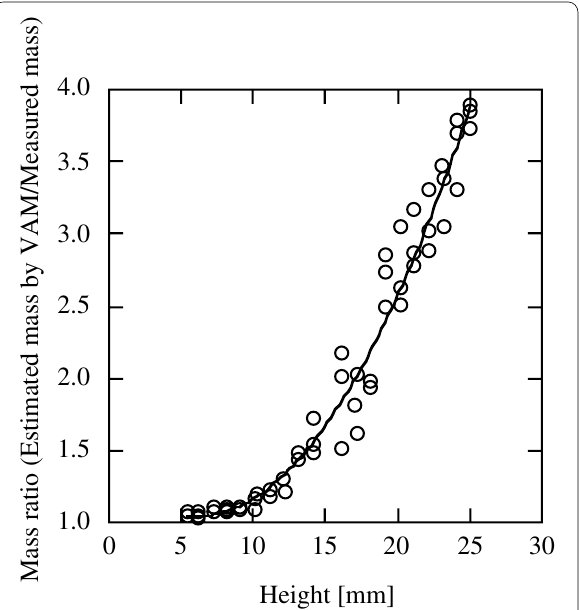
Fig. 6 Change in the mass ratio (estimated specimen mass by VAM/ measured specimen mass) that indicates the estimation accuracy of VAM with respect to the specimen